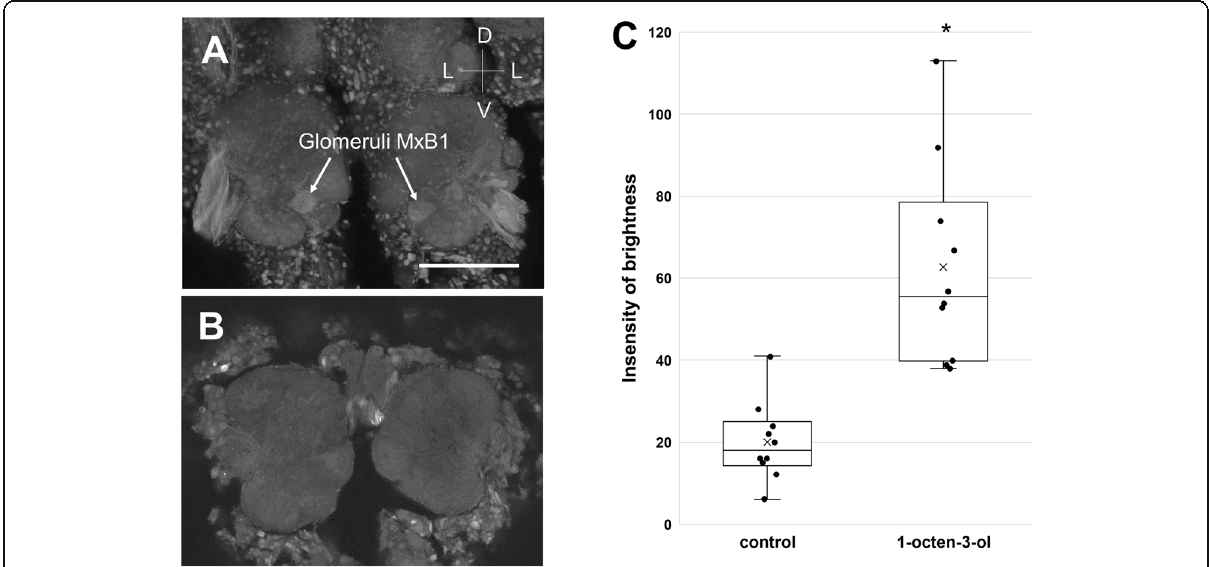
Fig. 7 AL glomeruli activated by 1-octen-3-ol odor stimulation via maxillary palps a A pair of glomeruli MxB1 labeled by anti-pERK antibody staining. b Control image without odor stimulation. The bar indicates 100 μ m. c Boxplot comparing the brightness of activated glomeruli MxB1 in the test ( n = 10) with the background brightness in the control ( n = 10). Boxplot whiskers are 1.5× interquartile